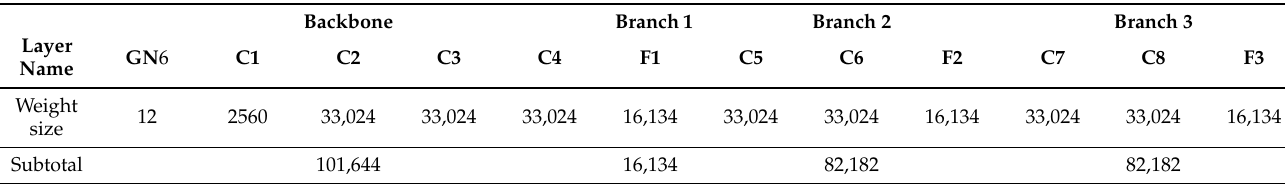
Table 1. The size of the proposed neural network model. The total number of weights in the model is